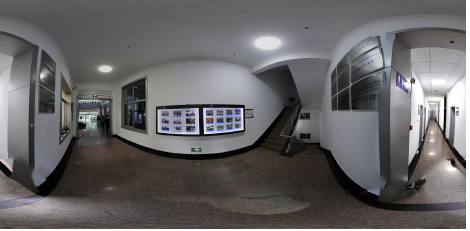
Figure 2. Panoramic image of the experimentation